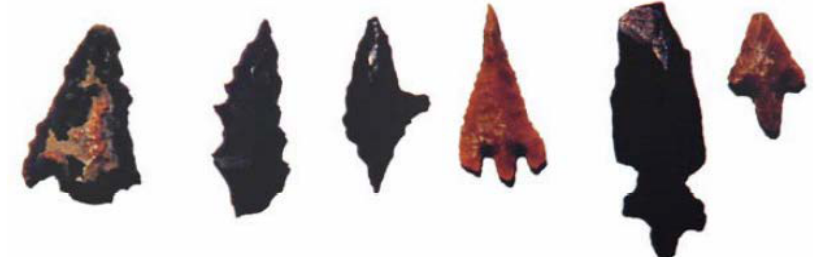
Figure 21. Neolithic stone objects from Jubbah, from the period to which some of the petroglyphs there are